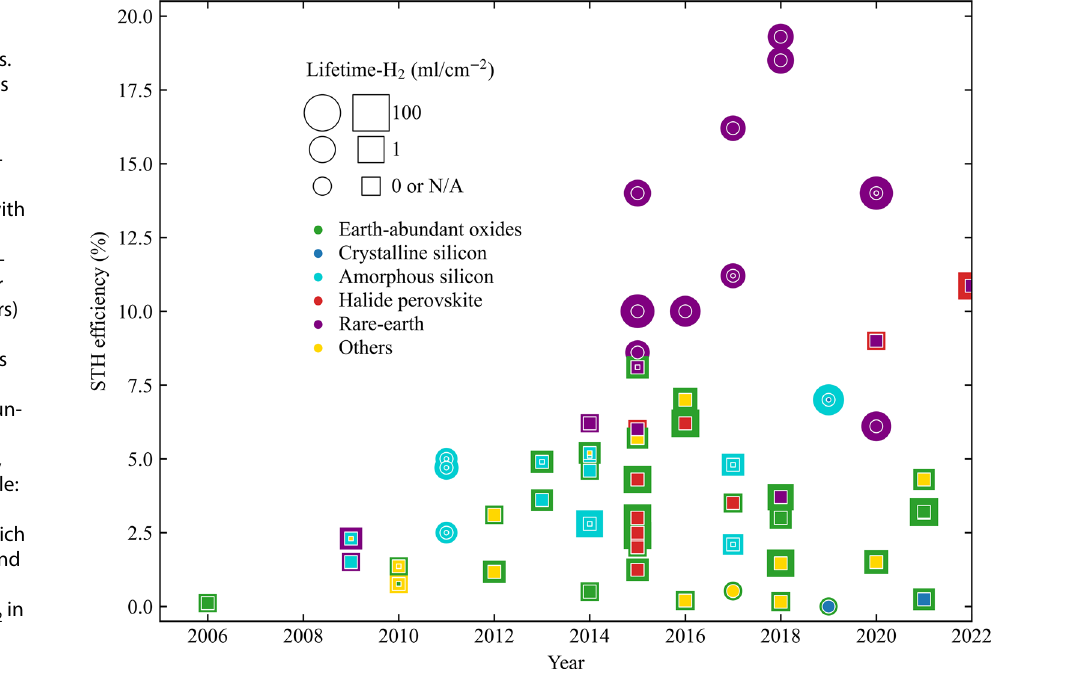
Fig. 6 STH efficiency from the previous studies [7, 8, 11, 21, 26–74] over the years. The shape of the data points represents the inclusion of SSJ-T in a device structure (circle: not included, rectan- gle: included). The colors of outer, middle (for devices with three light absorbers) and inner circle or rectangle cor- responds to top, middle (for devices three light absorbers) and bottom cell materials, respectively. Different colors represent different light absorbers (green: earth-abun- dant oxide, blue: crystalline Si, light blue: amorphous Si, red: halide perovskite, purple: any materials containing In, As or Ge, yellow: others, which are mostly chalcogenides and organics). The size of data- point represents lifetime-H log